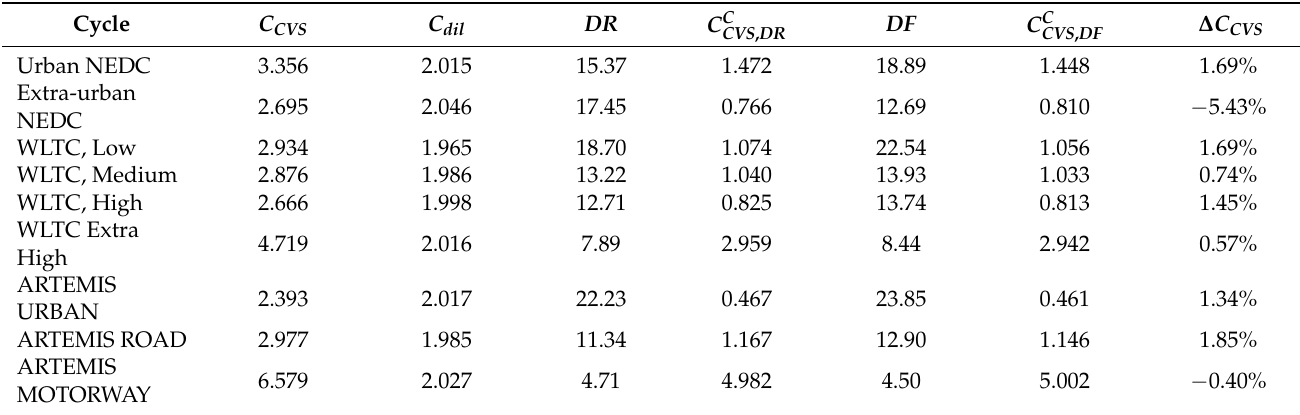
Table A10. The C CVS,corr calculated based on Equations (5) and (21) for Euro 6 NEDC vehicle with SI engine, CH 4 concentration [ppm].